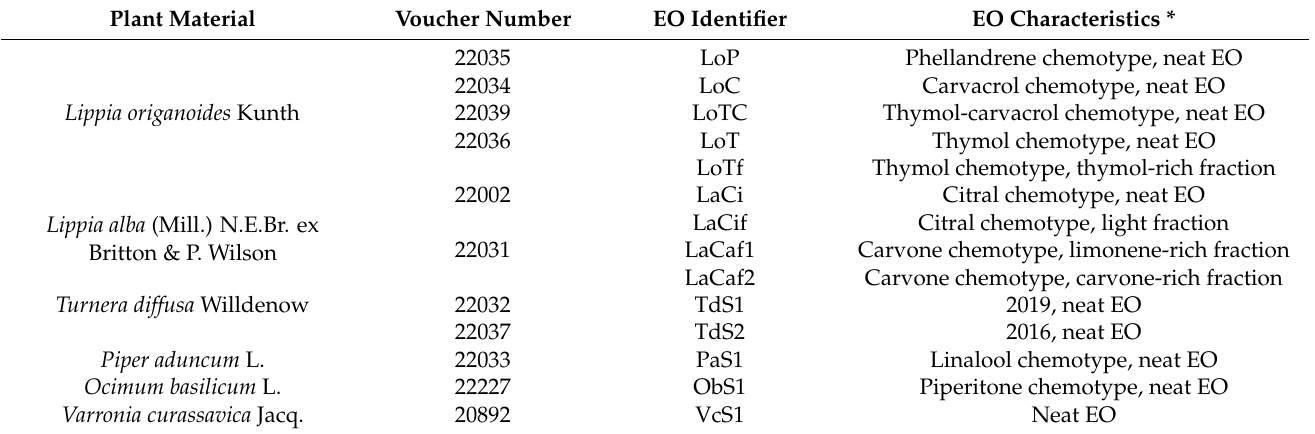
Table 1. Essential oils studied in this